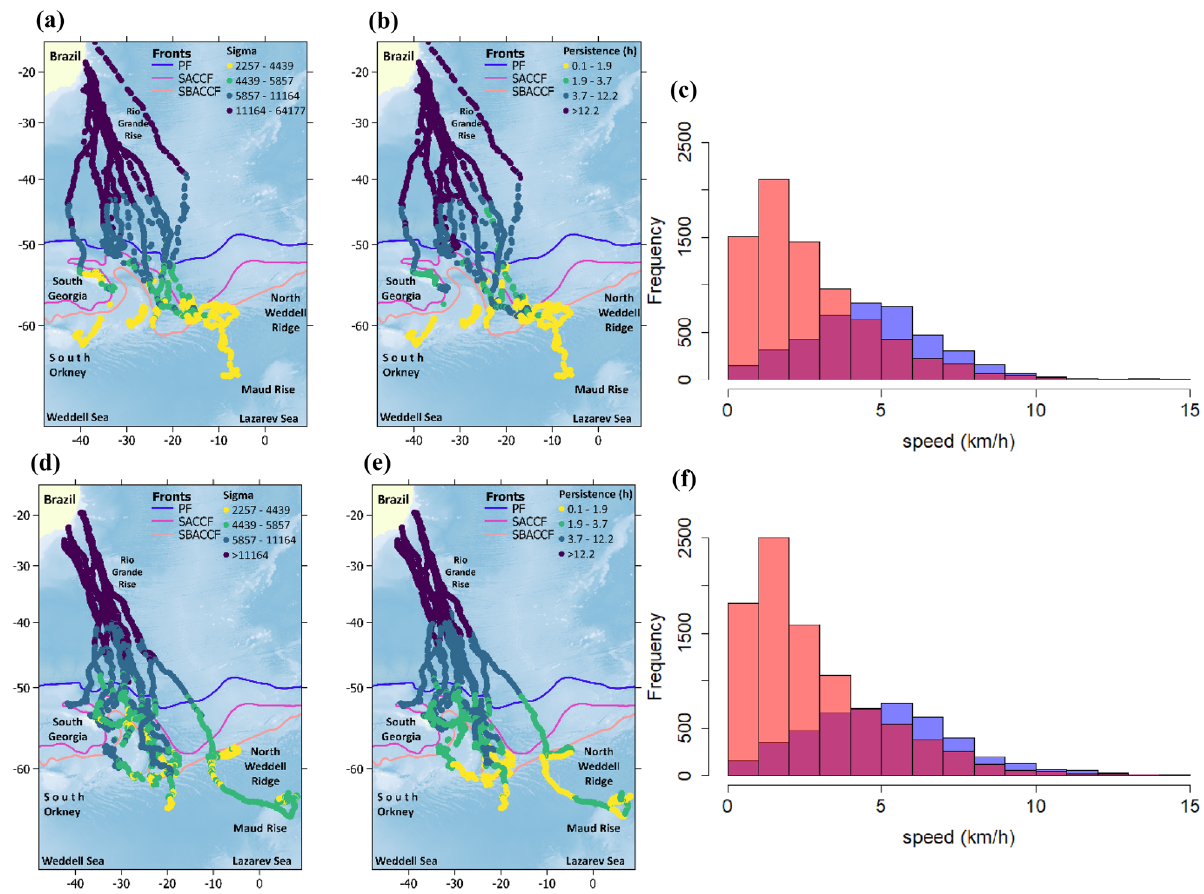
Figure 2. Estimated change in sigma (σ t ) and persistence ( p t = 3/β t ) for humpback whales according to the best P-Model, which included sex differences in parameters controlling movement response to environmental covariates. Overlapping histograms, show speed distribution north (blue) and south (pink) of the 50°S (purple shows the overlap between areas by transparency). Panels a to c show these variables for mothers and panels d to f for males + . Colored lines denote the location of polar front (PF), Southern Antarctic Circumpolar Current Front (SACCF), and the southern boundary of the Antarctic circumpolar current (SBACCF). Antarctic circumpolar fronts data is made publicly available by the Australian Antarctic Data Centre (https:// resea rchda ta. edu. au). Data layers (including maps) were created in R ver. 4.0.2 (www.r- proje ct. org) and ensembled in QGIS ver. 3.8.0 (www. qgis. org) for final rendering. Maps were created using data on bedrock topography from